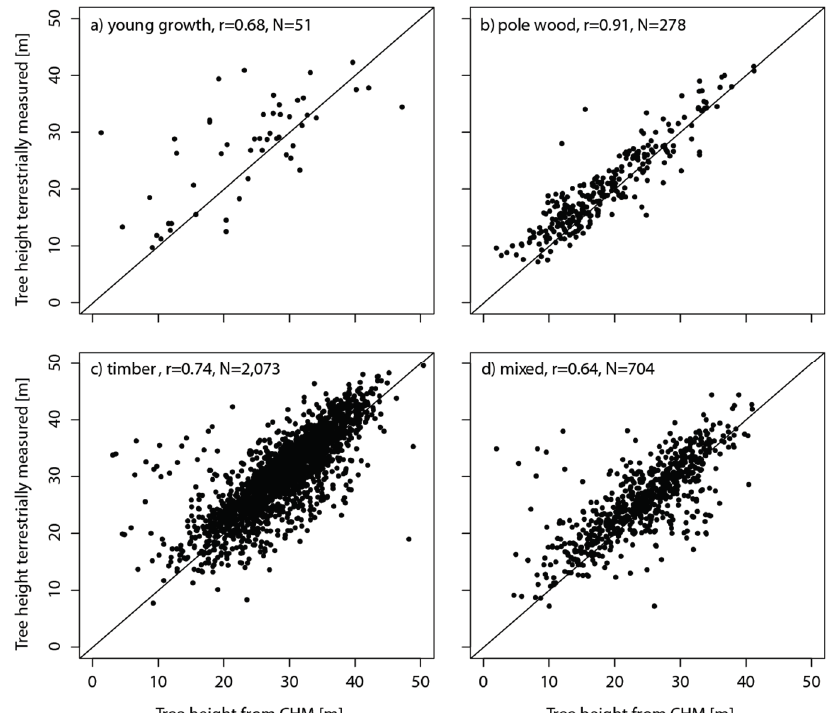
Figure 7. Comparison of canopy height from the CHM with terrestrially measured canopy height at the NFI sample plot level. One of the four stages of stand development was assigned to each sample plot. ( a ) Young growth refers to regeneration areas with a medium tree height of 8 m; ( b ) pole wood refers to stands with a high number of stems and a mean tree height of 8–20 m; ( c ) the timber stage is characterized by closed stands with a mean height > 20 m; and ( d ) mixed refers to stands where there are different stages of stand